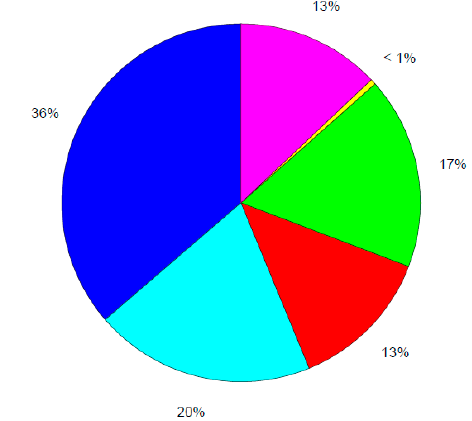
Figure 13. Pie chart that comparatively shows the total time consumed by each of the phases of MONICOD. The pink color represents the time dedicated to the validation algorithm (13%). The other phases are presented and described exhaustively in [1]. They are enhancement image (blue), equalization (light blue), band separation(green), ink association (red), and grouping